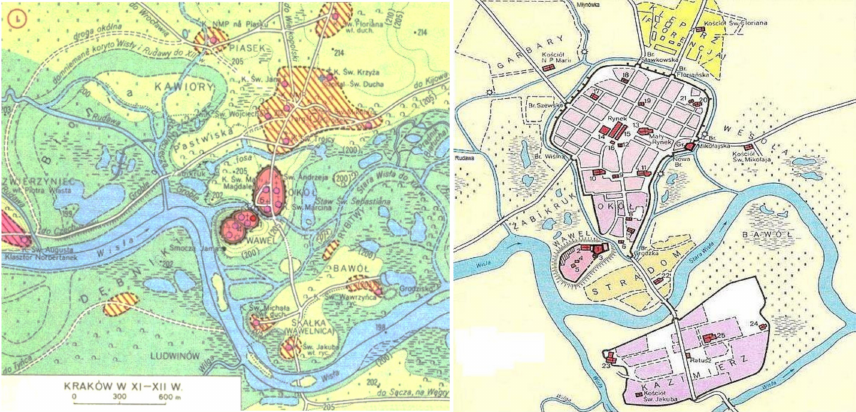
Figure 2. Pre-colection settlement layout of Cracow from the 11th/12th century (on the left ) and the urban location layout from the 13th/14th century (on the right